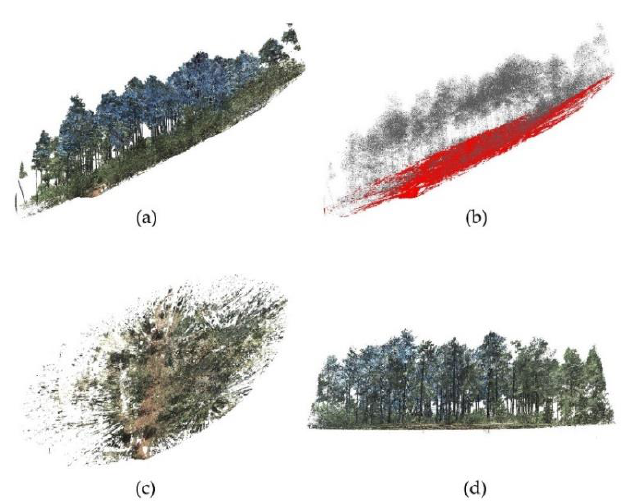
Figure 4. Normalization of point cloud height. ( a ) Original point cloud data acquired using TLS; ( b ) Filtering results with ground points in red and non-ground points in gray; ( c ) Ground points with RGB color; ( d ) Points with normalized height.